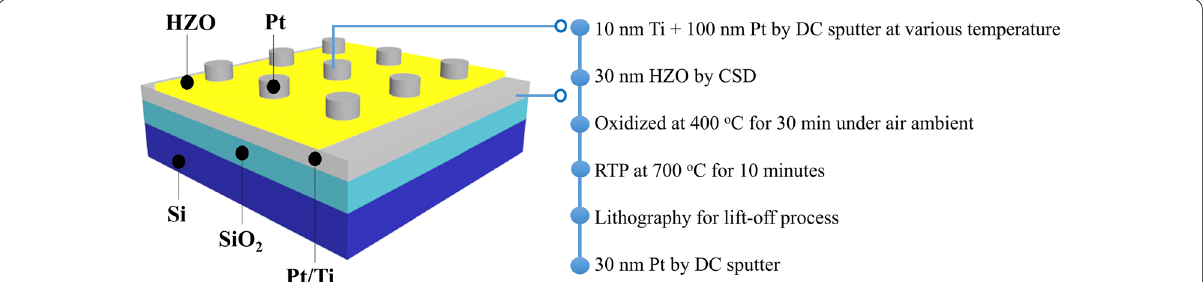
Fig. 1 MFM structure with HZO thin film on Pt substrates with various grain sizes and the